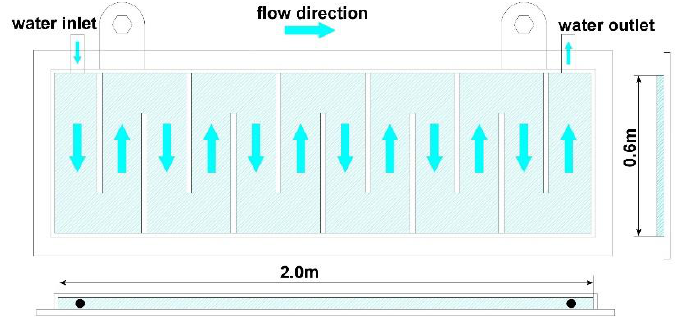
Figure 1. Structure of the water cooling plate.